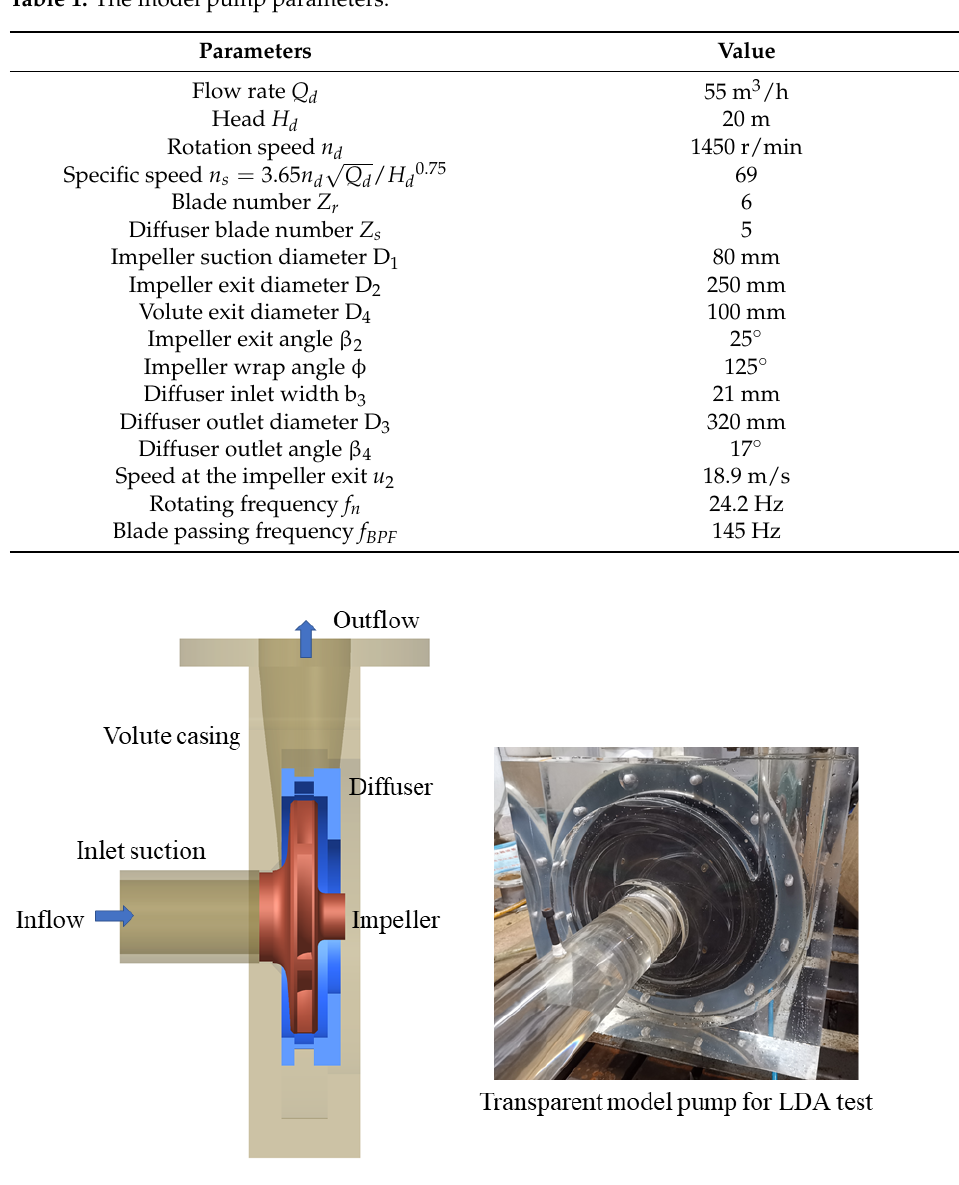
Figure 1. The transparent model pump was used for investigation. Table 1. The model pump